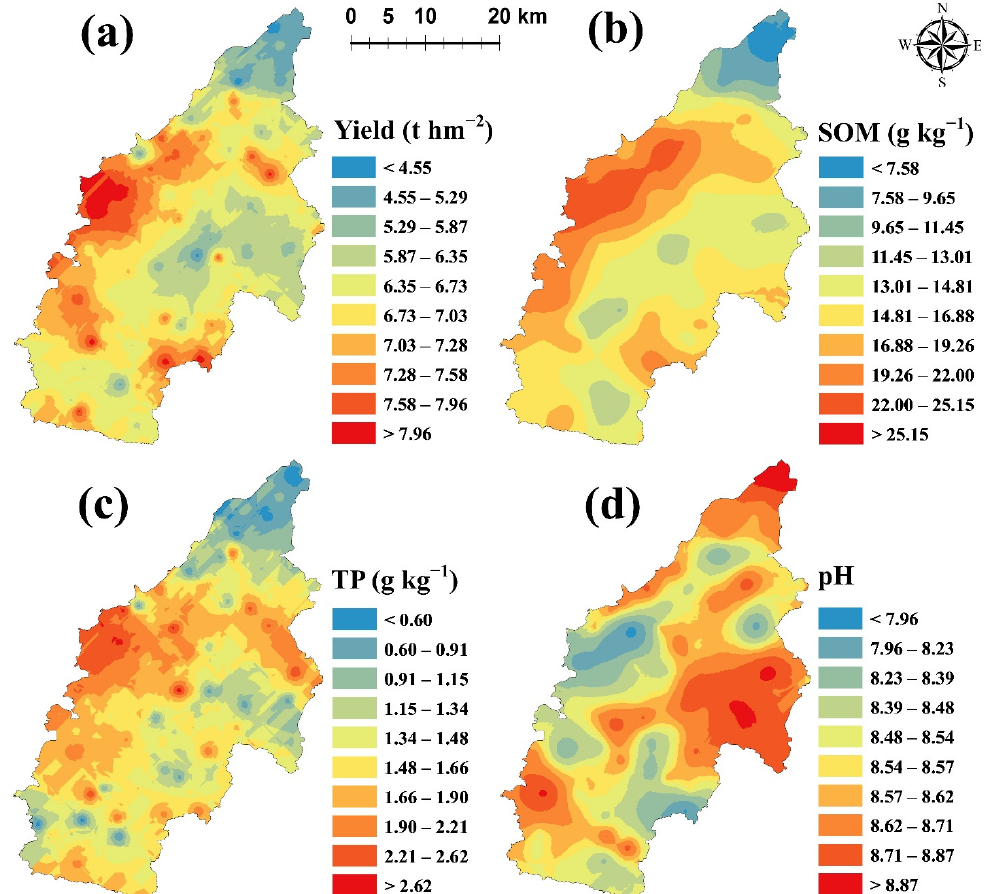
Figure 2. Spatial distribution maps generated by robust ordinary kriging (ROK) for ( a ) wheat yield, ( b ) soil organic matter (SOM), ( c ) soil total phosphorus (TP), and ( d ) soil pH. Table 3. The medians of the standardized square prediction error ( SSPE ) generated by leave-one- Table 5. Validation indices a for the regression models calculated based on the 99 pairs of the out cross-validation. measured yields and predicted Wheat Yield